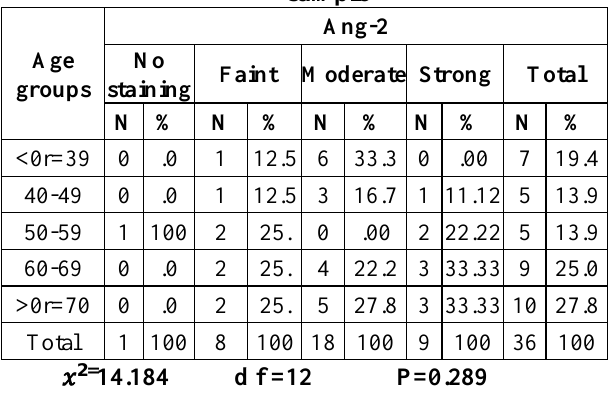
Table 4: Association between Ang-2 expression and Age group in the study sample